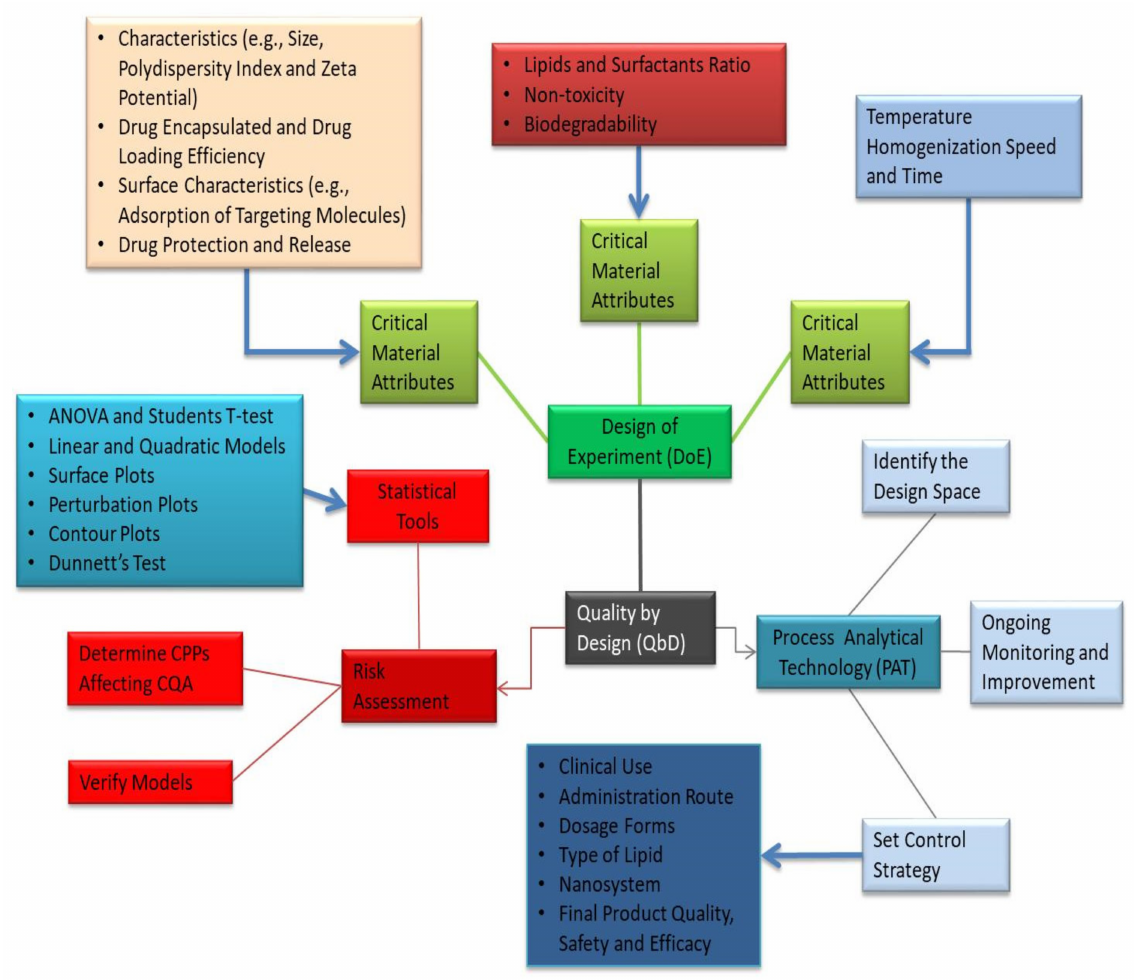
Figure 7. Generalized overview of QbD involved in the development of